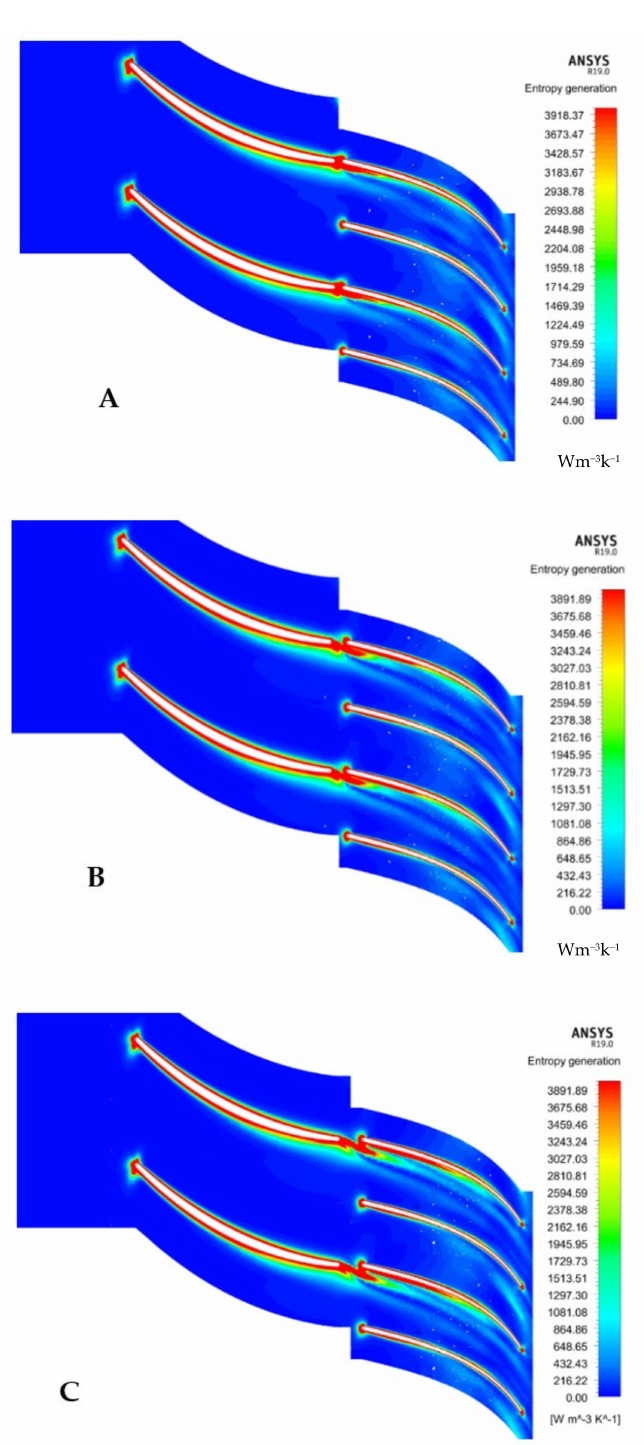
Figure 24. Entropy generation map at 50% span, 0% clock. Axial gap 0.5 mm ( A ), 1 mm ( B ), and 1.5 mm ( C ). m r =